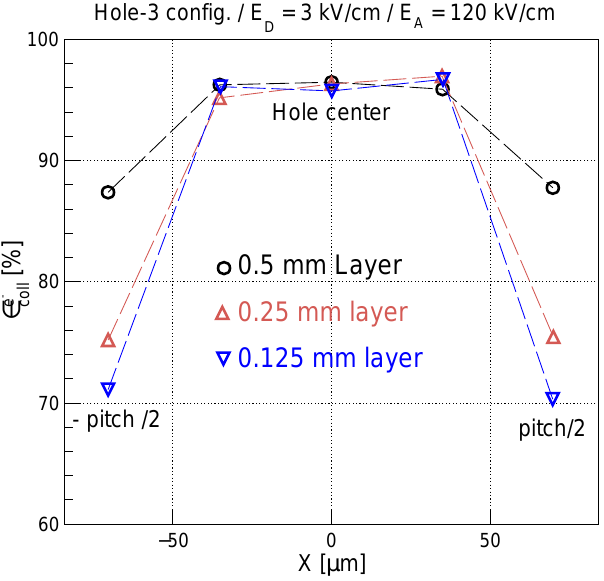
Figure 12. Electron collection efficiency vs. initial electron x-position. Efficiency declines when the electron is created away from the hole center. There is more than 10% loss in collection efficiency in a 0.25 mm layer and more than 15% loss in a 0.125 mm layer when compared to a 0.5 mm thick